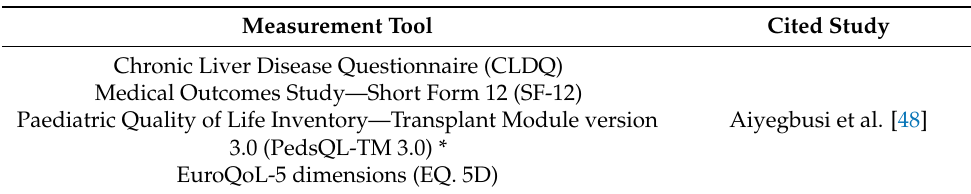
Paediatric Quality of Life Inventory—Transplant Module